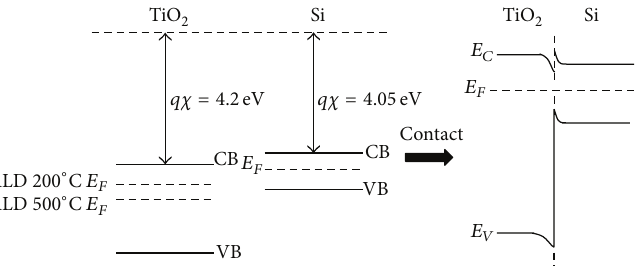
Figure 8: The left hand side is energy band diagrams of TiO 2 and Si before contact. After contact, band bending occurs at the interface of TiO 2 and Si.